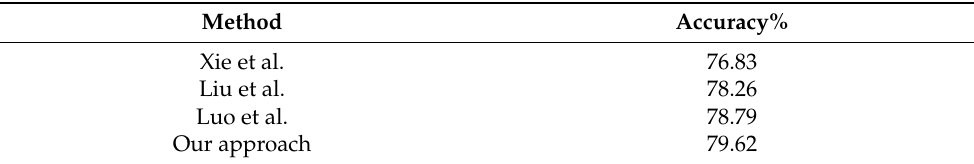
Table 6. Comparison results with other models.